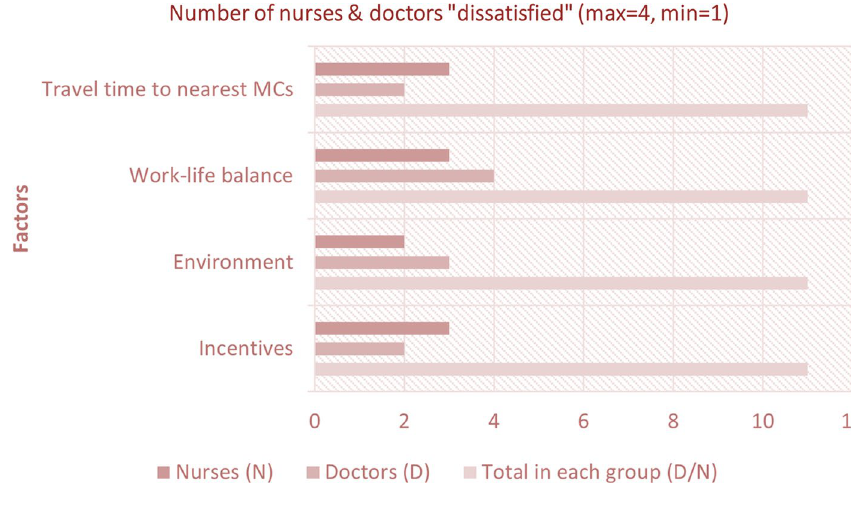
Fig. 6 Horizontal bar graph illustrating the number of people (nurses and doctors) dissatisfied with the scheme and services of mohalla clinics considering four different